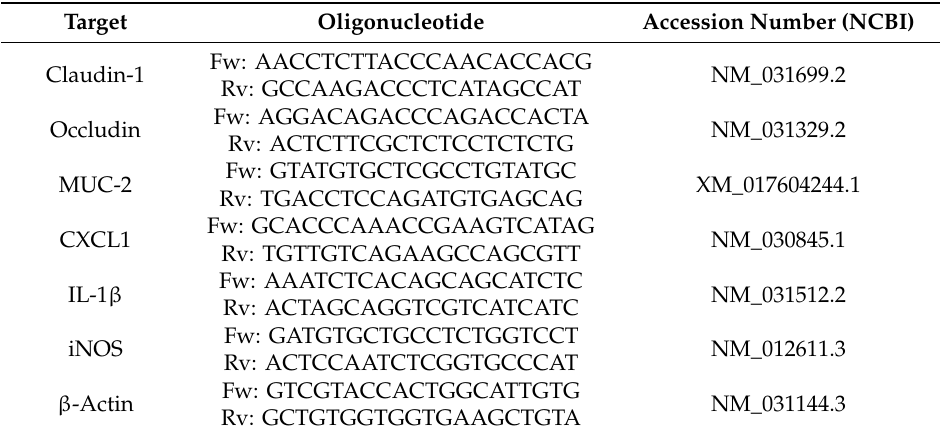
Table 1. Primers used in this study.